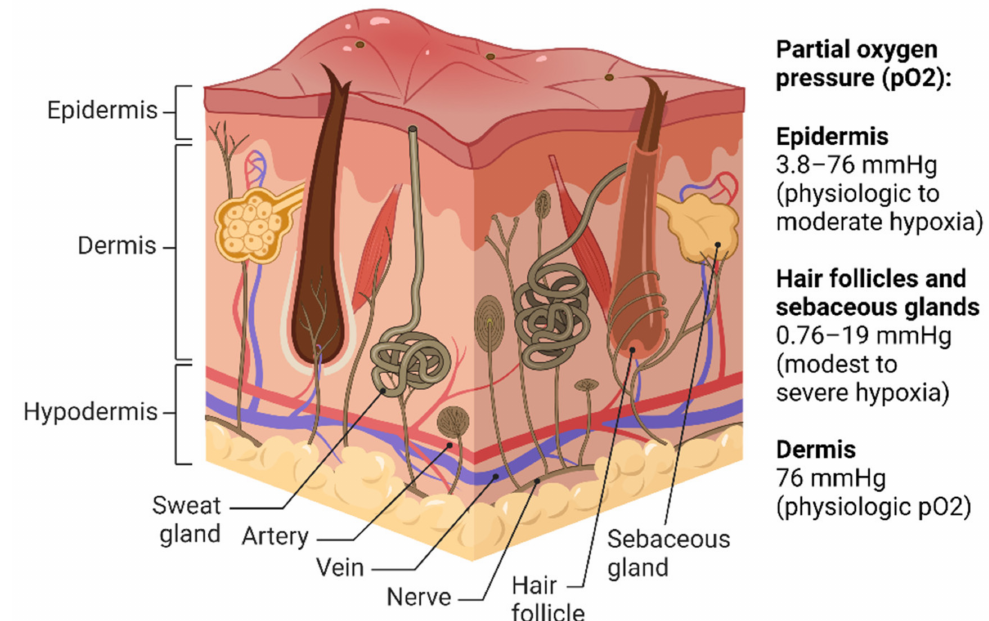
Figure 1. Oxygen levels in different parts of the human skin (created with BioRender.com). Skin cancer commonly originates from epidermal cells and later infiltrates deep into the dermis and subcutaneous layers. Three main types of epidermal cells develop into skin cancer: basal cells, squamous cells, and melanocytes. Basal cells lie at the base of the